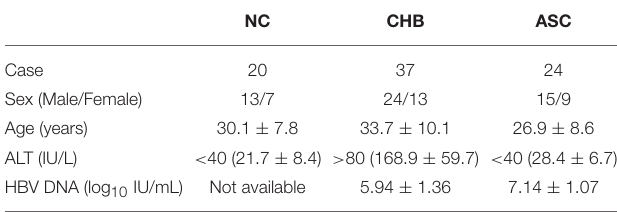
TABLE 1 | Baseline clinical characteristics of enrolled